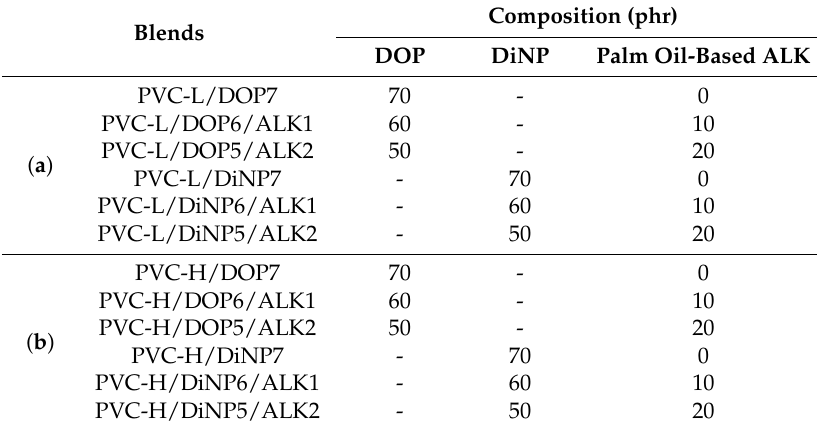
Table 1. Formulation of palm oil-based alkyd with ( a ) PVC-L/DOP and PVC-L/DiNP blends and ( b ) PVC-H/DOP and PVC-H/DiNP blends. Poly(vinyl chloride) TL-700 (PVC-L).